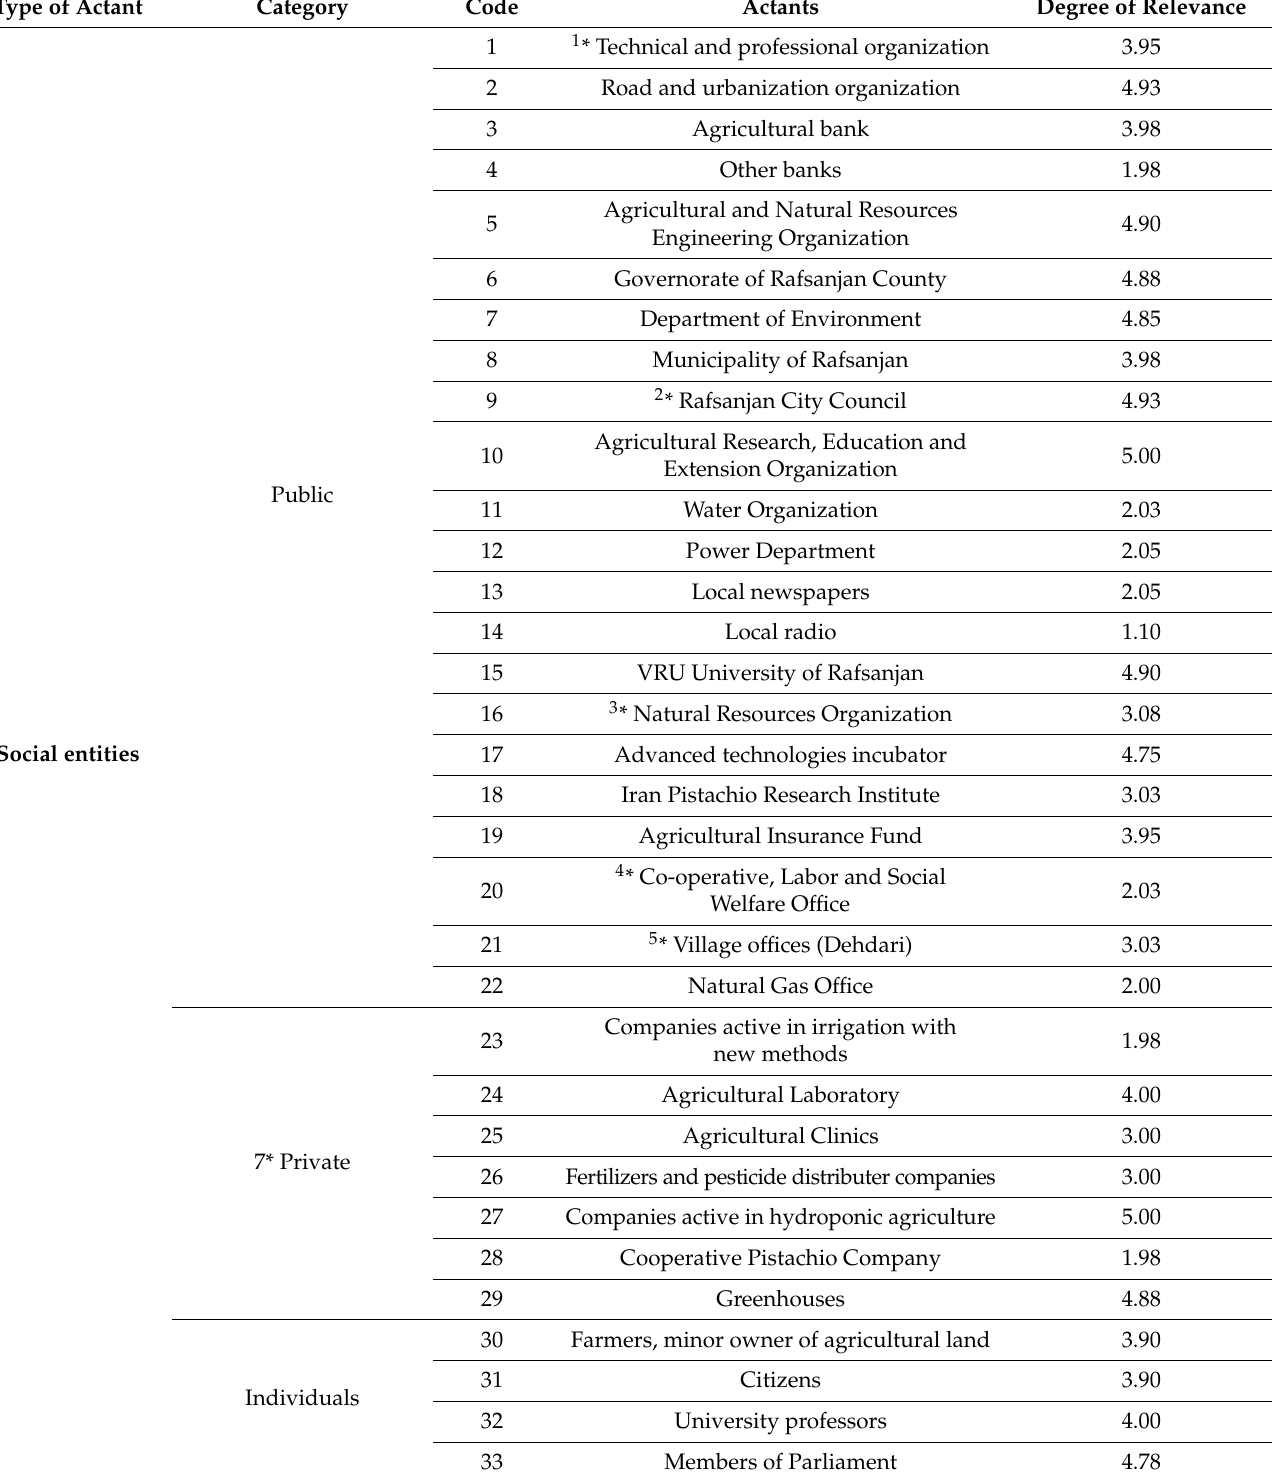
Table A1. List of actants involved in the transition of the agricultural sector in Rafsanjan and their degree of relevance on a scale of 1 (not relevant) to 5 (very